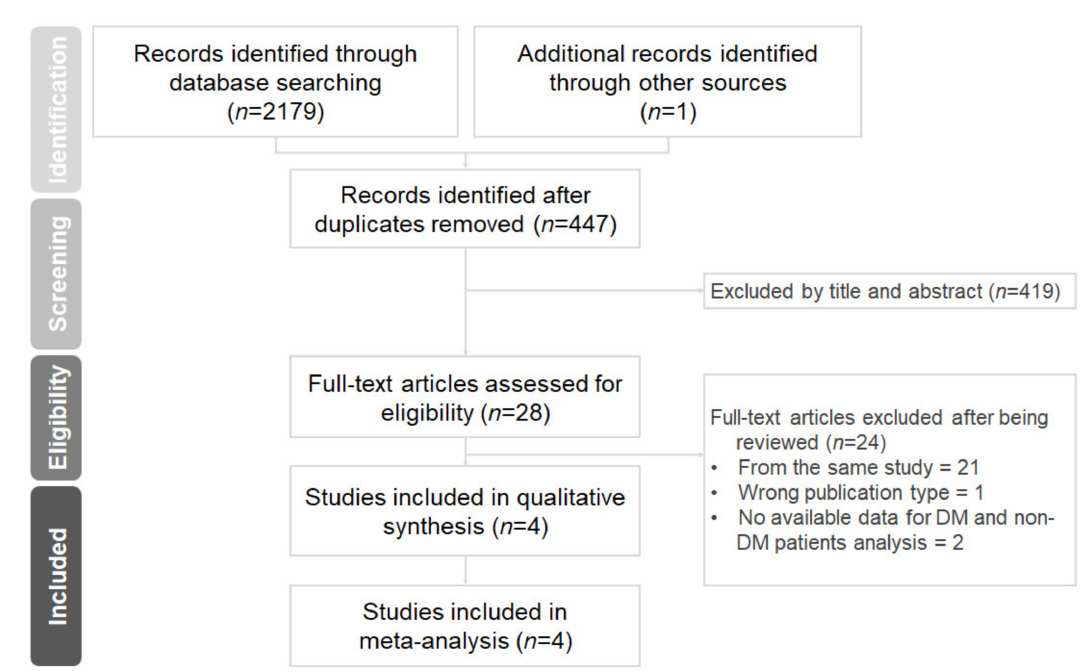
Figure 1. Preferred Reporting Items for Systematic Reviews and Meta-Analyses (PRISMA) diagram for the searching and identification of included